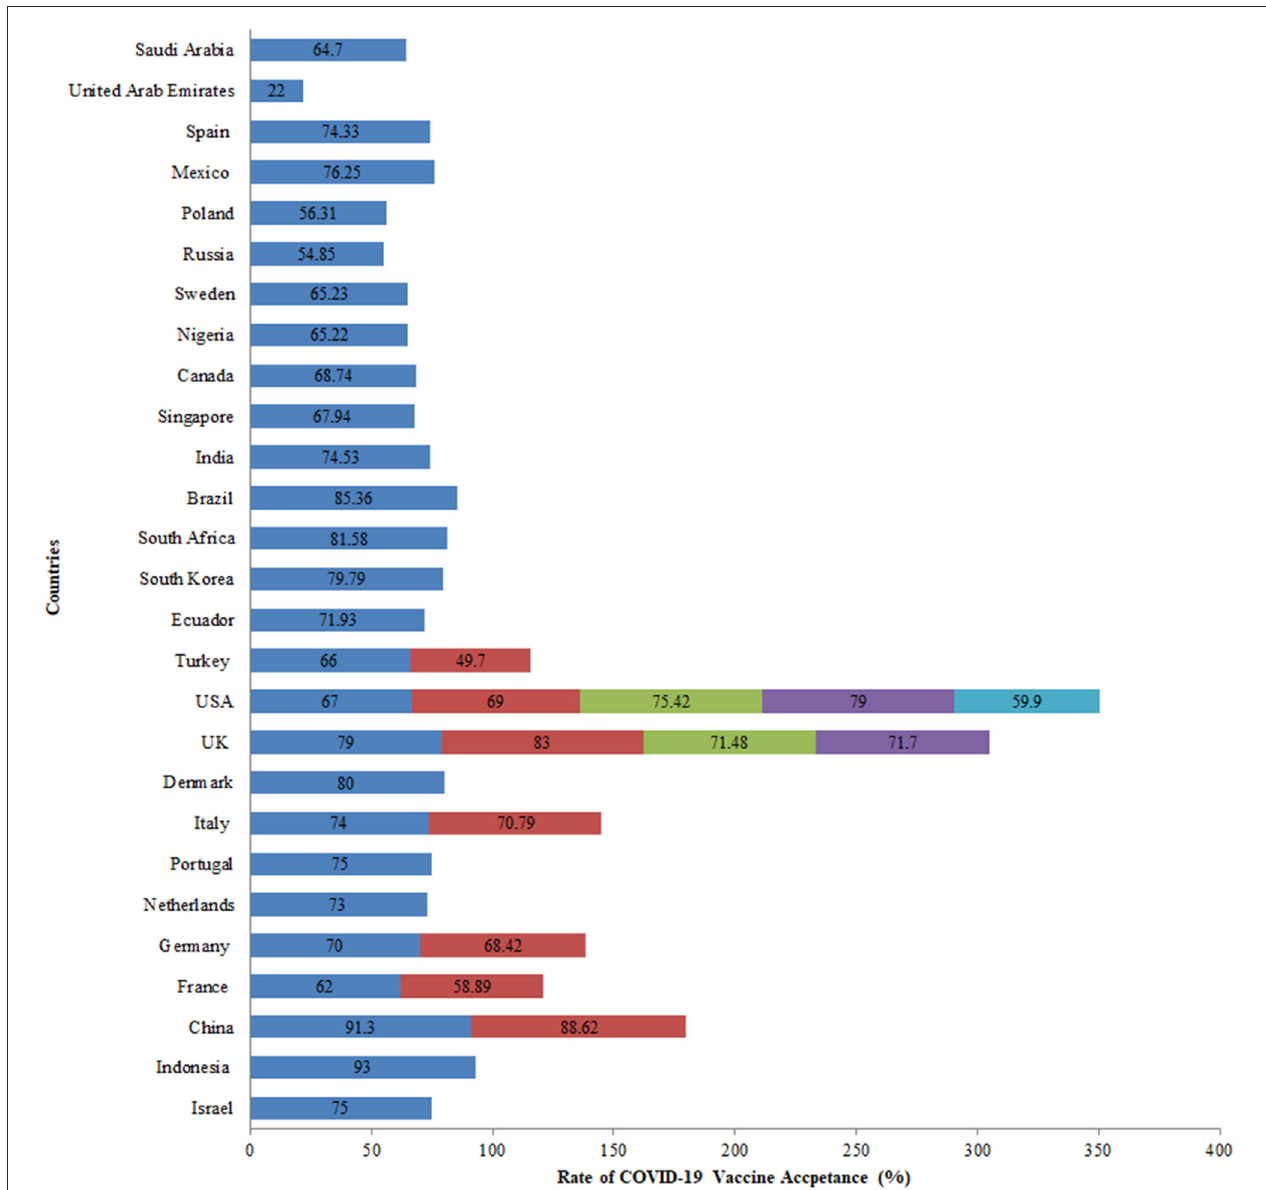
FIGURE 4 | COVID-19 vaccine acceptance rates among the general population across various countries.